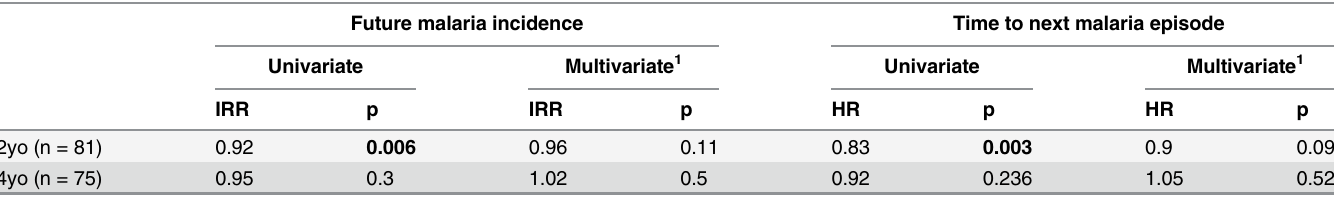
Table 1. Relationship between T reg frequencies and prospective risk of